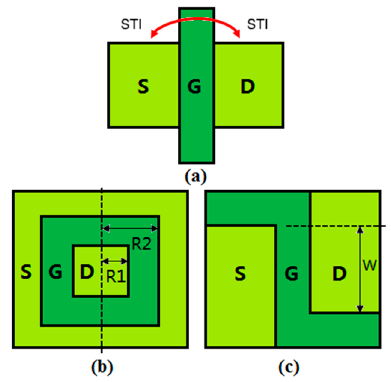
Figure 1. Schematic structures of ( a ) the conventional layout, ( b ) the H gate layout, and ( c ) the proposed layout. STI, shallow trench isolation.